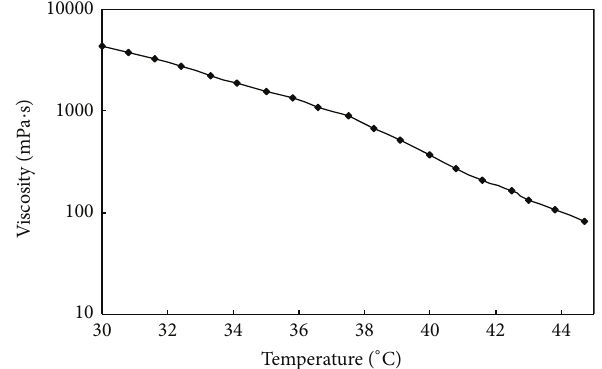
Figure 2: Viscosity versus temperature for oil.